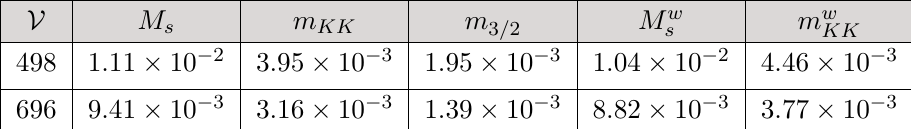
Table 4. Physical scales associated with the solutions in table 3, for the parameter set in table 2. The mass scales are expressed in units of M p